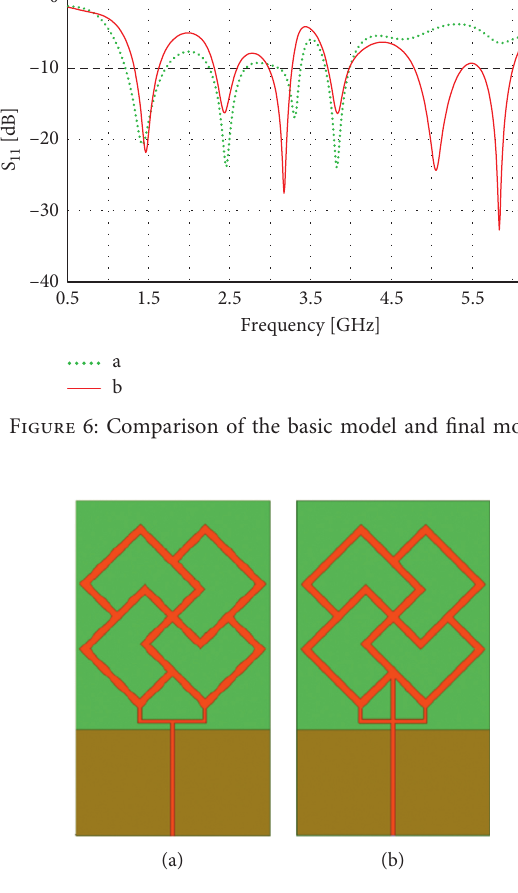
Figure 7: Comparison of microstrip line feed structure. (a) Double-dent structure. (b) Trident structure.